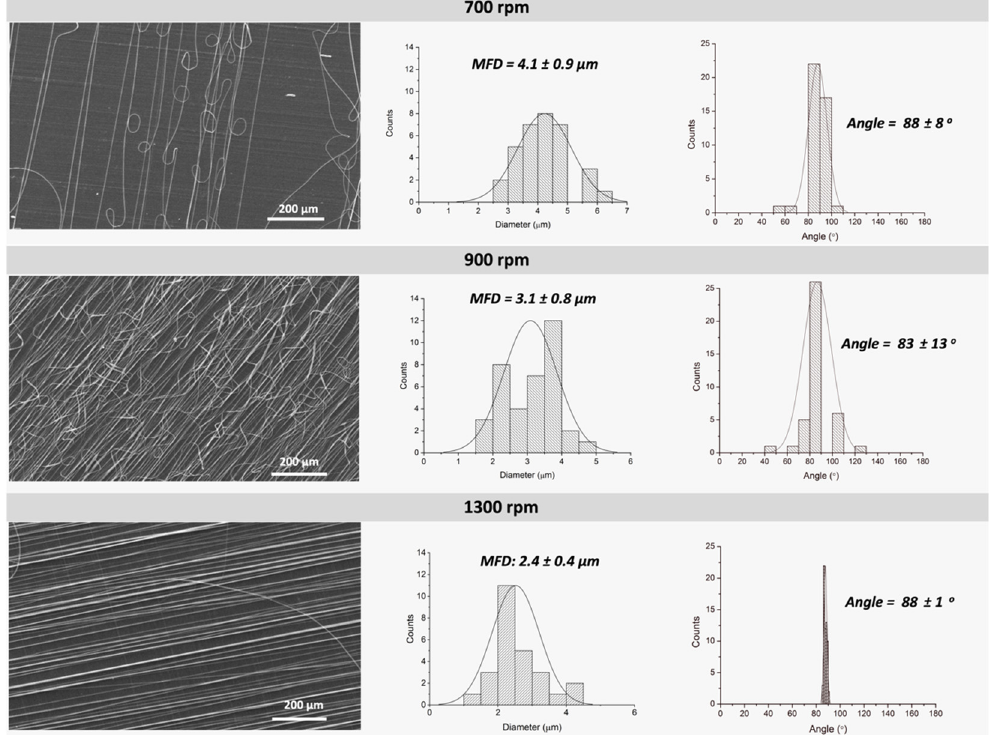
Figure 4. SEM micrographs of PLA fibers (20 wt.% PLA, 90:10 CHCl 3 :DMF) with their respective histograms corresponding to mean fiber diameter (MFD) and orientation as a function of rotor velocity. (Electrospinning fixed parameters: 16 kV, needle-to-collector distance 12 cm and feeding rate of 1.0 mL/h).